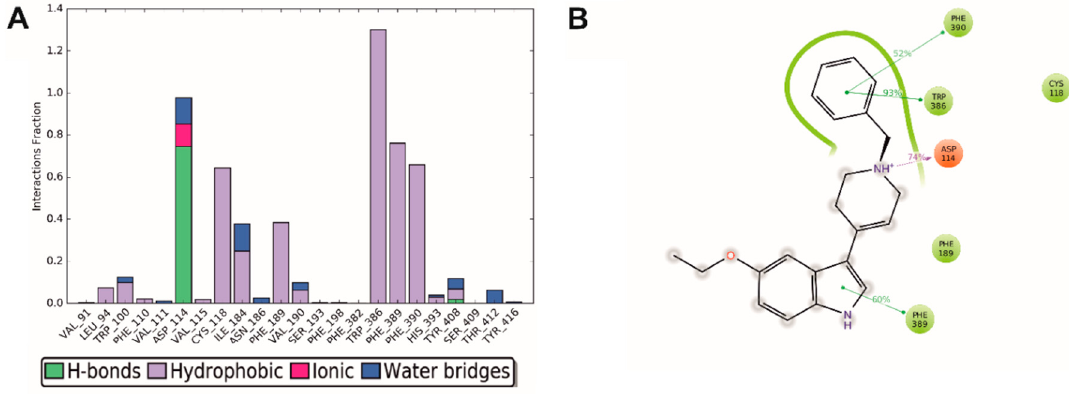
Figure 7. Molecular interactions of D2AAK1_3 with human dopamine D 2 receptor during 100 ns molecular dynamics simulations. ( A ) histogram of interactions. The stacked bar charts are normalized over the course of the trajectory: For example, a value of 0.7 suggests that 70% of the simulation time the specific interaction is maintained. Values over 1.0 are possible as some protein residue may make multiple contacts of same subtype with the ligand. ( B ) summary of contacts. Interactions that occur more than 30.0% of the simulation time in the selected trajectory (0.00 through 100.00 ns), are shown.